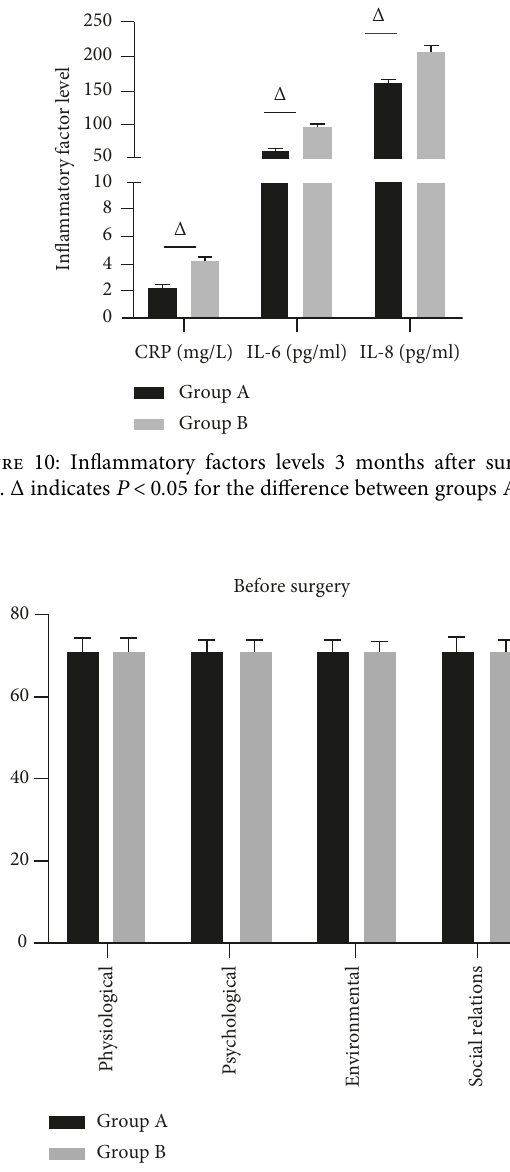
Figure 11: WHOQOL-BREF score before